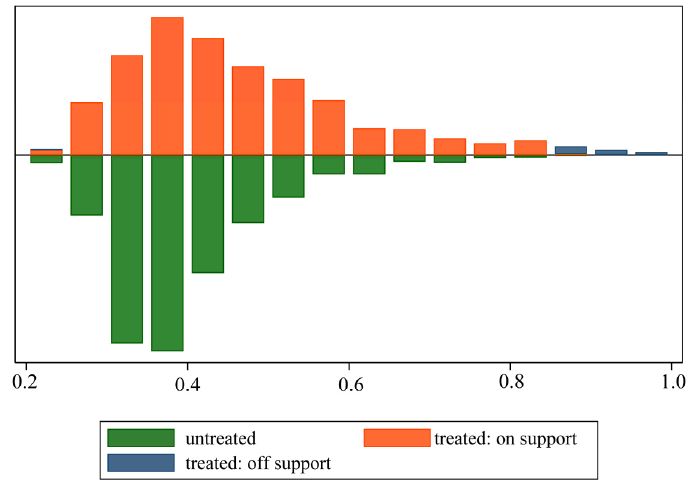
Figure 3. The distribution of propensity scores for the treatment and control groups. Table 3. Comparisons of sample characteristics of unmatched and matched in PSM.